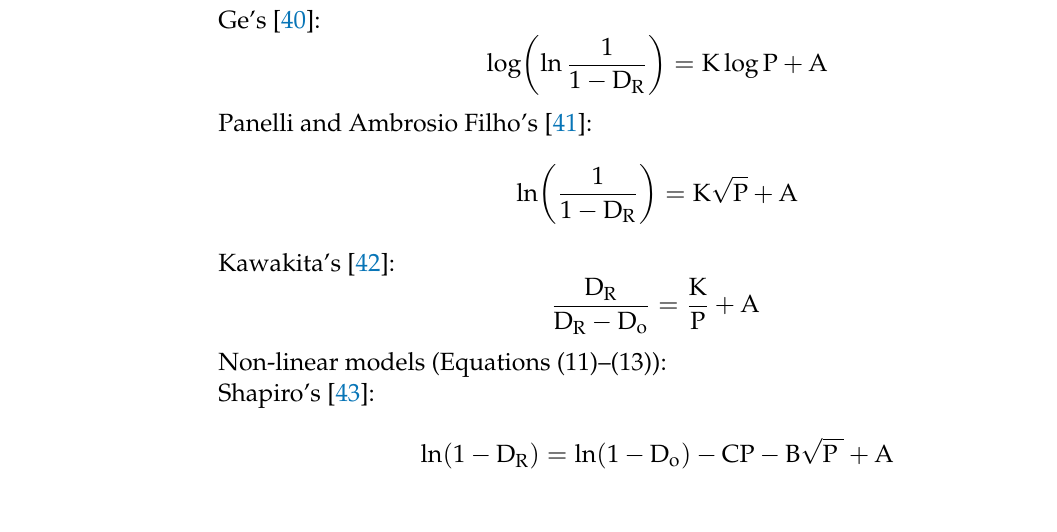
Figure 9. HRSEM SE microstructures and EDS overlay map of green compacts pressed at 1100 MPa of three developed HEAs after stress recovery: ( a – c ) FeCrCuMnTi; ( d – f ) FeCrCuMnTiV; and ( g – i ) FeCrCuMnTiVZn.